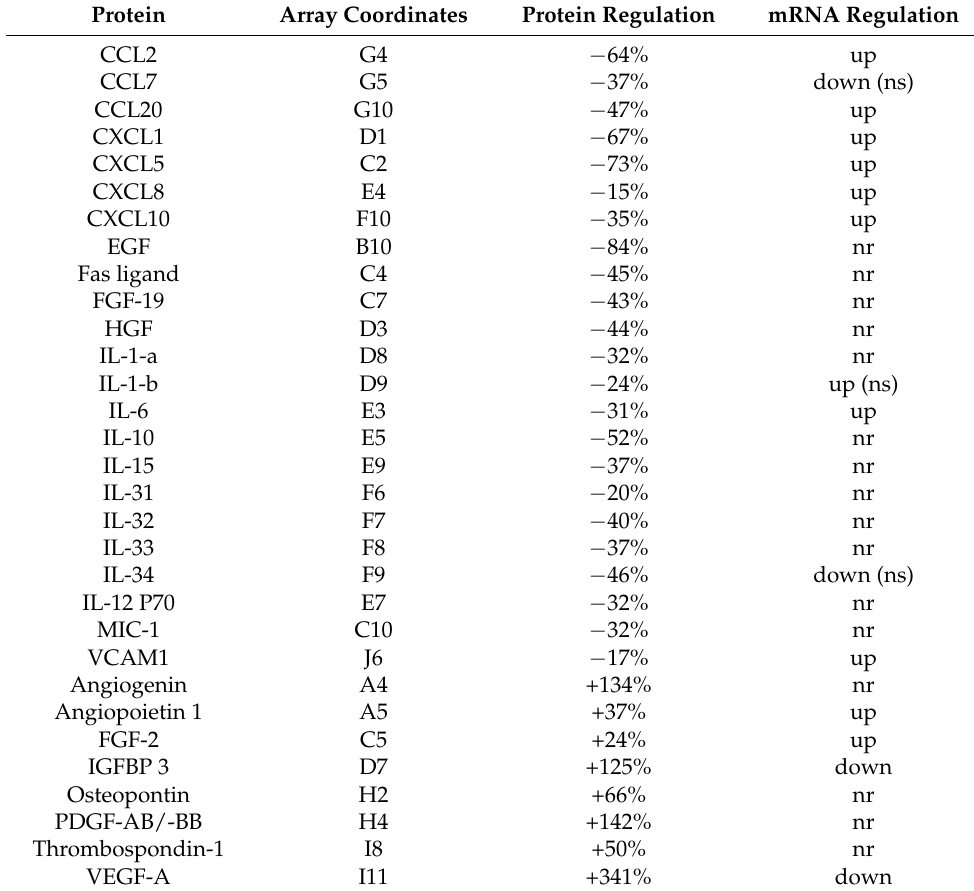
Table 4. List of differentially expressed proteins using a cytokine proteome array. Protein Array Coordinates Protein Regulation